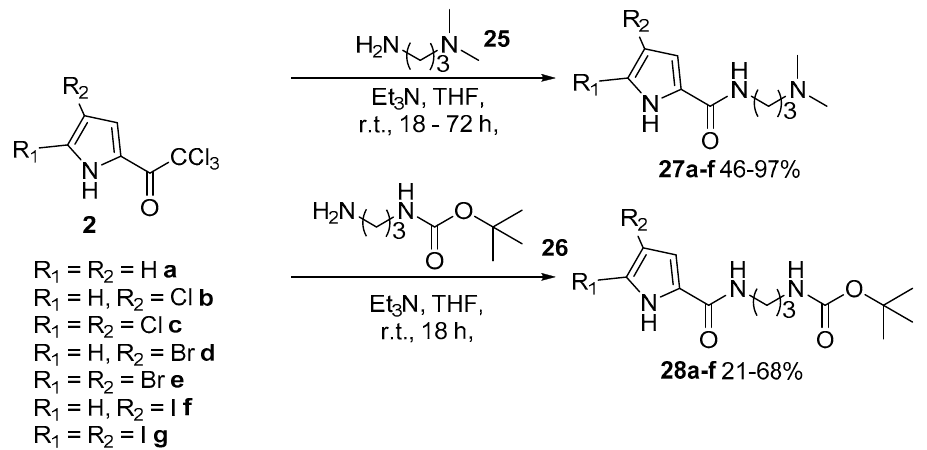
Table 2. Antibacterial activity of all synthesised analogues in comparison to standard antibiotics. Compound.